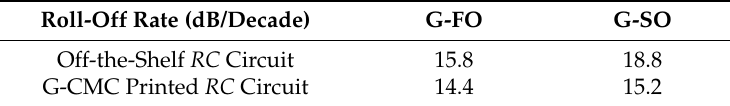
Figure 6. First-order low pass filter performance of RC-FO, G-FO1 and G-FO2. Note that the f c was same for both G-CMC circuits and roll off rate was lower than the conventional RC low pass filter. Table 2. Roll-off rate comparison of graphene-CMC passive filters.